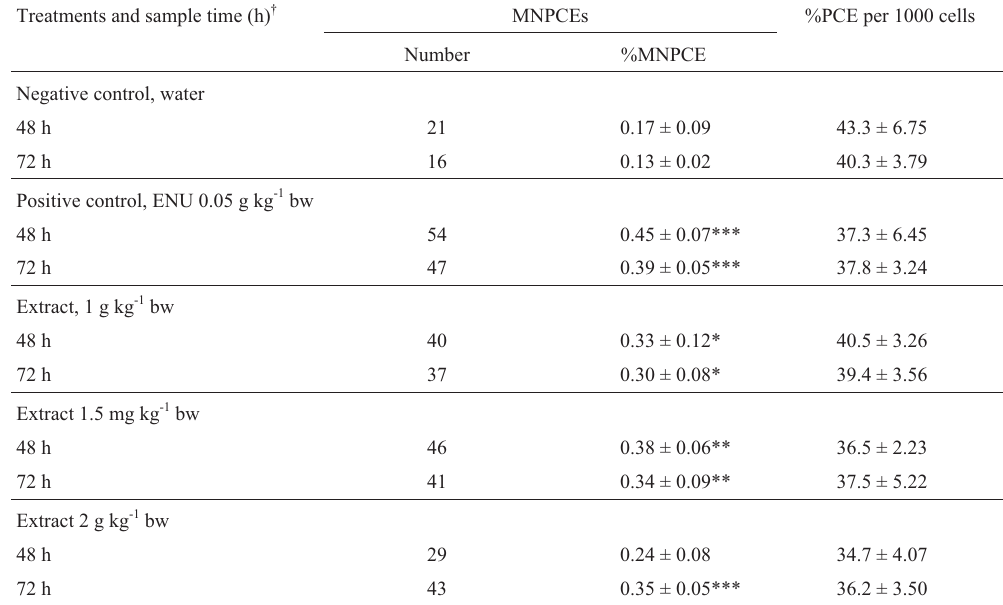
Table 2 - Peripheral blood micronucleus assay results for 12-week old Swiss mice treated with Vaccinium corymbosum hydroethanolic extract. Blood samples were taken 48 and 72 h after administration of different concentrations of extract. The negative control was water and the positive control was N-nitroso-N-ethylurea (ENU). For each mouse 12000 polychromatic erythrocytes (PCE) were scored for the number of micronucleated polychromatic erythrocytes(MNPCE)andthepercentagecalculated.ThepercentageofPCEper1000bloodcellsisgiveninthelastcolumn.ValuesshownareMeans± standard deviations for six mice per